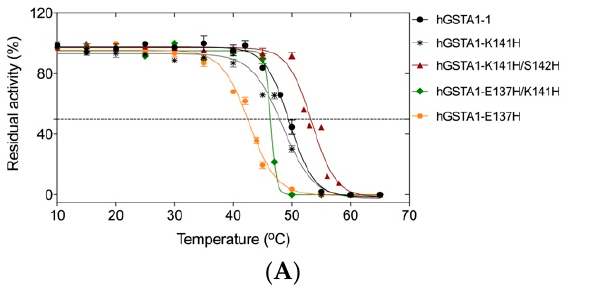
Figure 4. Effect of pH on enzyme activity for hGSTA1-1 and its mutants. Enzyme activity was measured in the standard assay reaction at 37 °C, at pH values ranging from 4 to 9, and using the appropriate buffers.